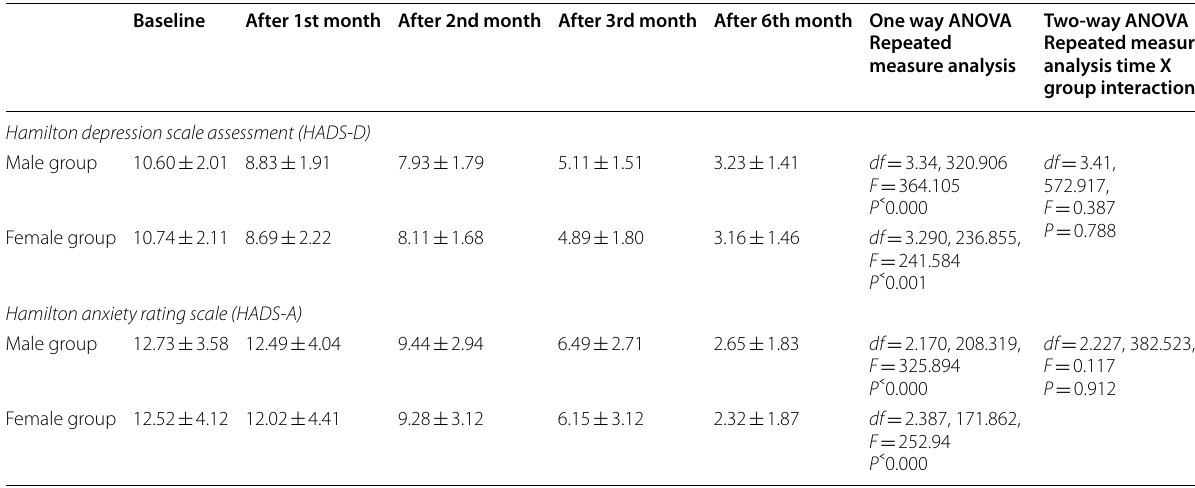
ANOVA Analysis of variance, HADS-D Hamilton depression scale assessment, HADS-A Hamilton anxiety rating scale